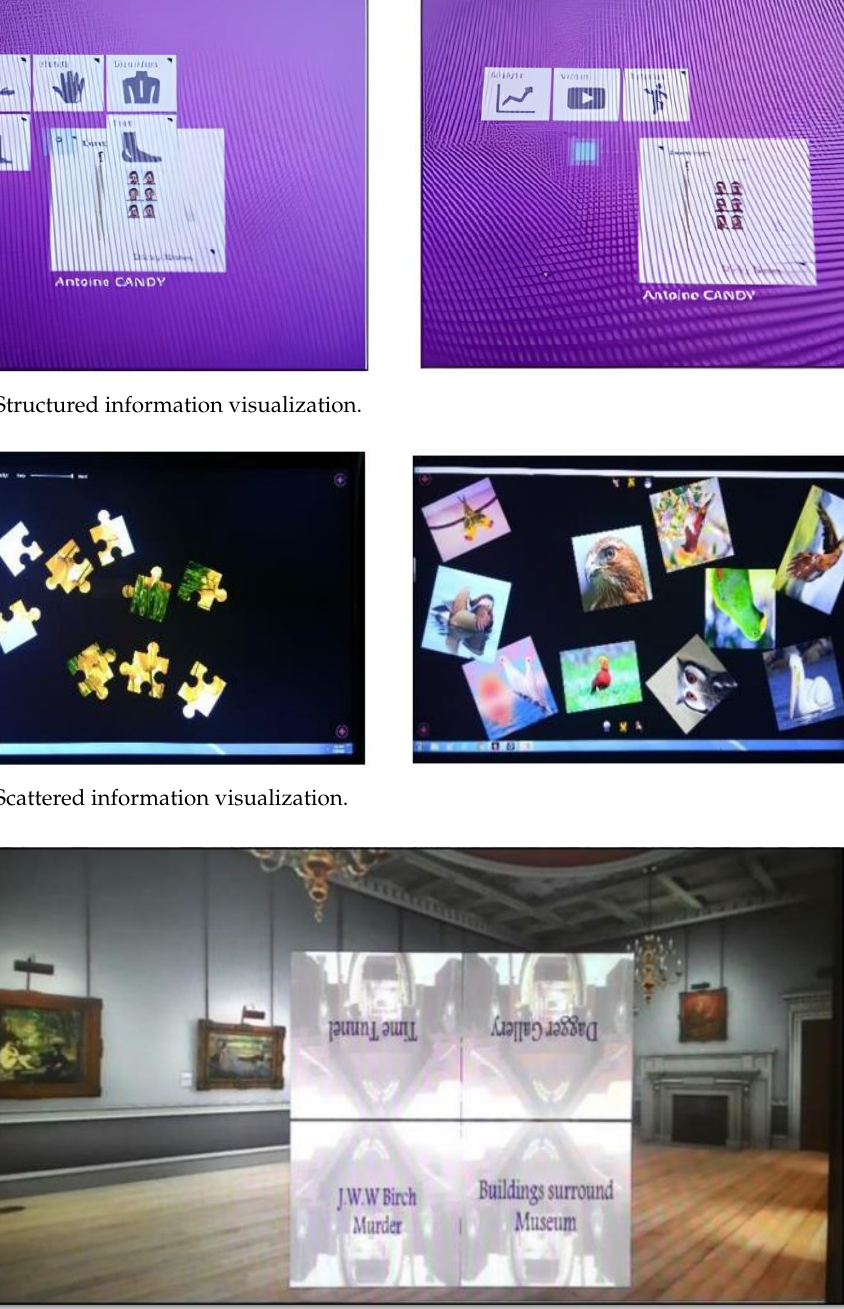
Figure 3. A top view of the Pasir Salak Museum interface as used in the preliminary study.